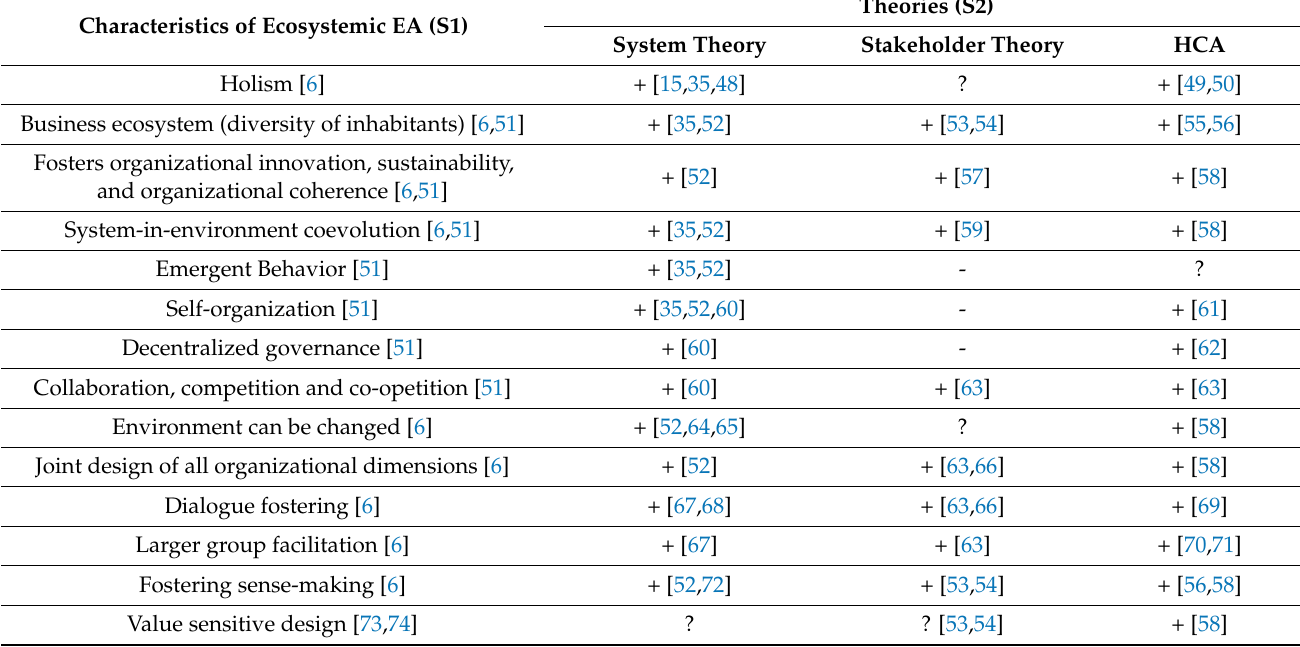
Table 1. Potential of selected theories to accommodate and expand ecosystemic